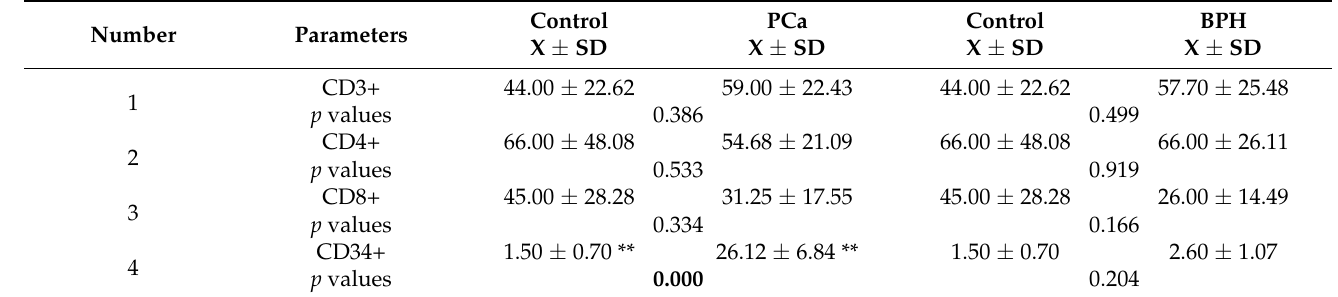
Table 5. Evaluation of T lymphocyte biomarkers and intratumoral expression of CD34 in prostate adenocarcinoma, benign prostatic hyperplasia, and non-malignant adjacent tissue samples.